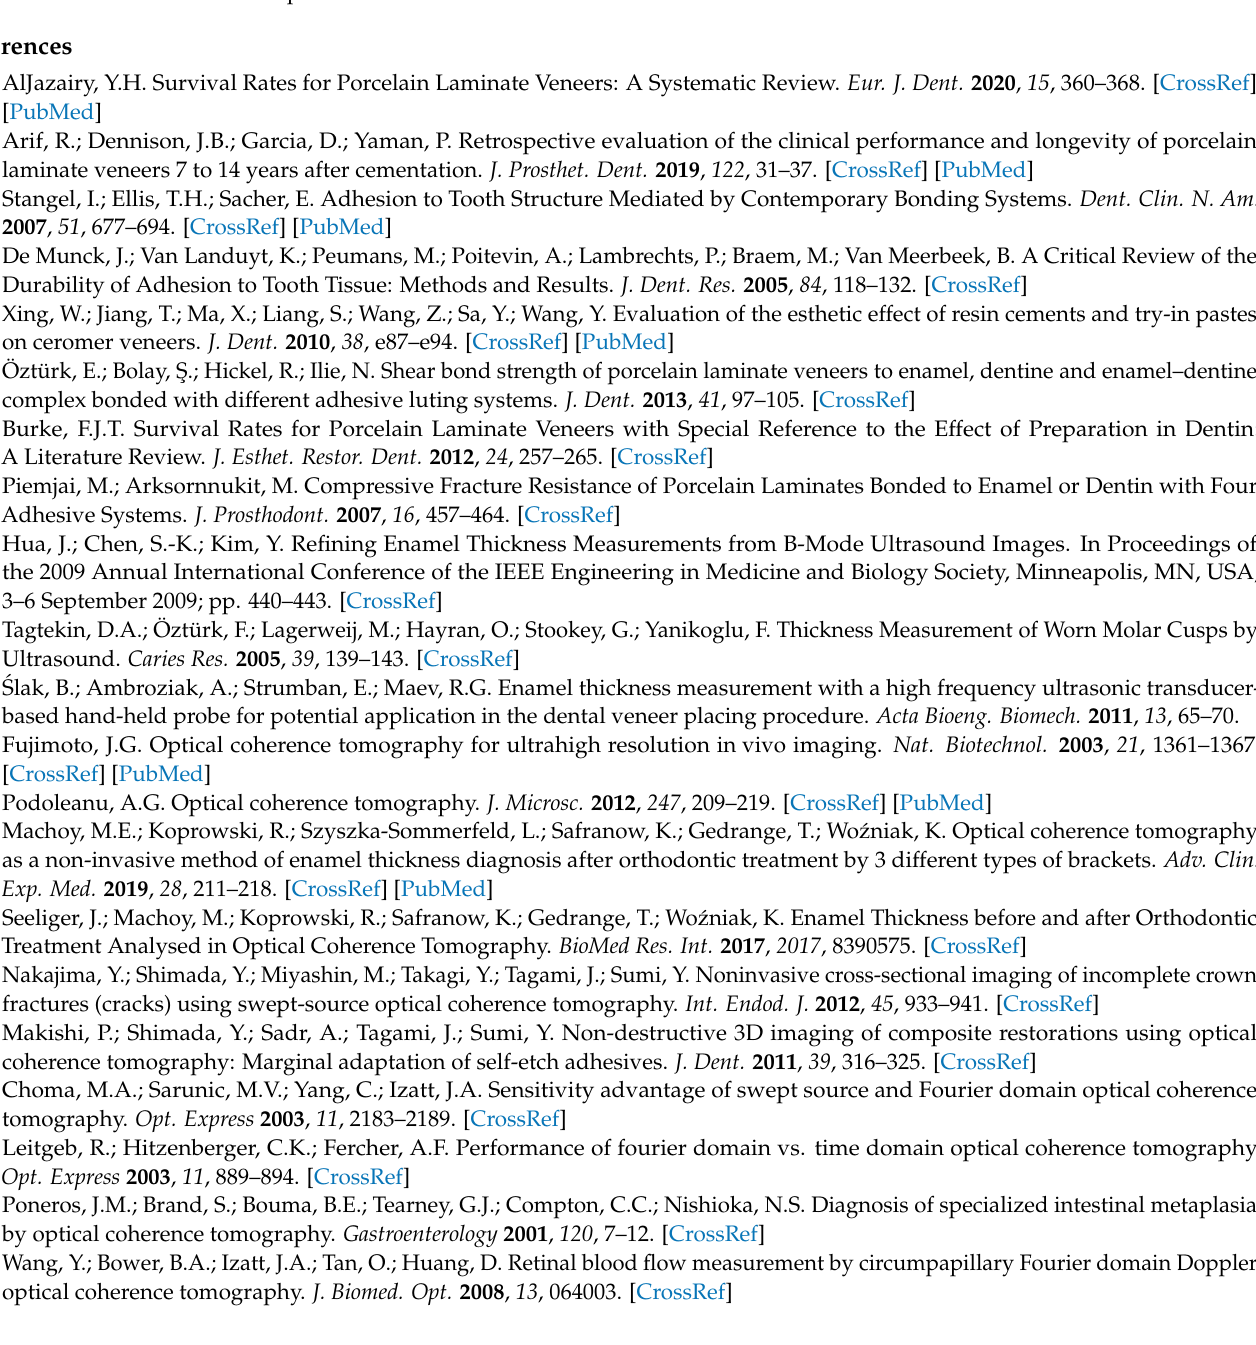
Figure A5. Optical microscopy image and measurement site. The distance ( e2 ) from the middle of the marks to DEJ perpendicular to the tangent of the middle of the marks was measured as the optical thickness.